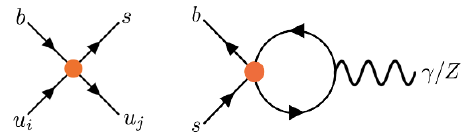
Figure 1 . Diagrams generating contributions to the 4-quark WET coe(cid:14)cients C 1 ; 2 (left) and to b ! sl + l (cid:0) (right) from the SMEFT operators Q (1) qq and Q (3) qq